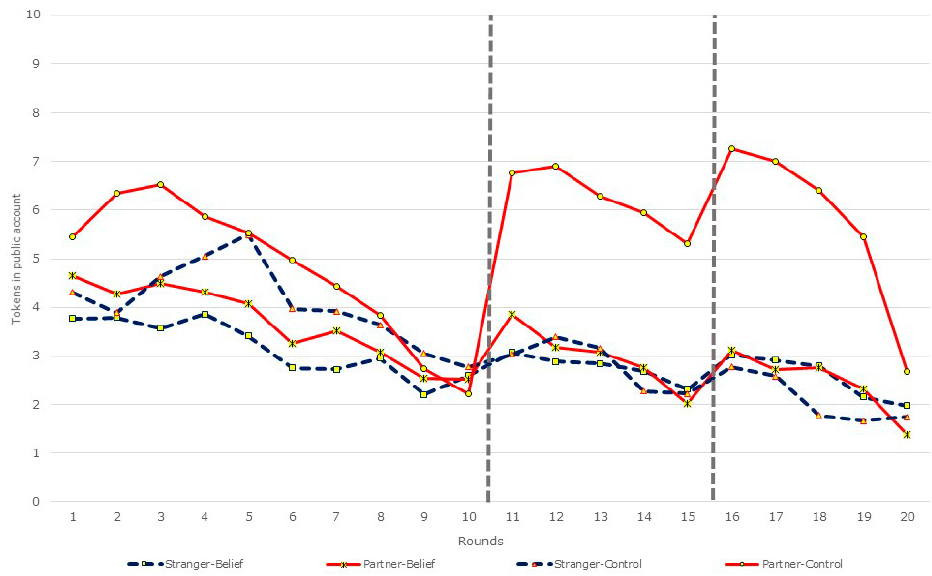
Figure 1. Overview of contributions over time. Thick dashed vertical lines indicate a